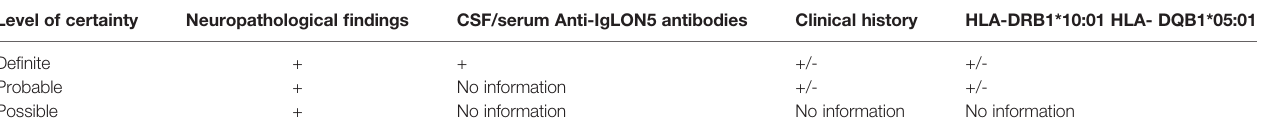
TABLE 1 | Anti-IgLON5 neuropathological diagnostic criteria. Level of